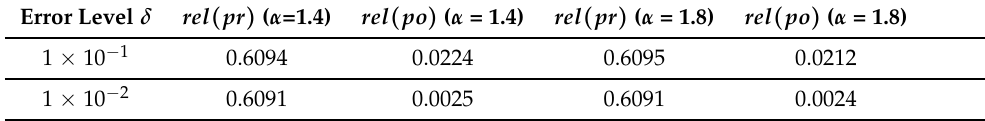
Table 3. The relative error of Example 3.